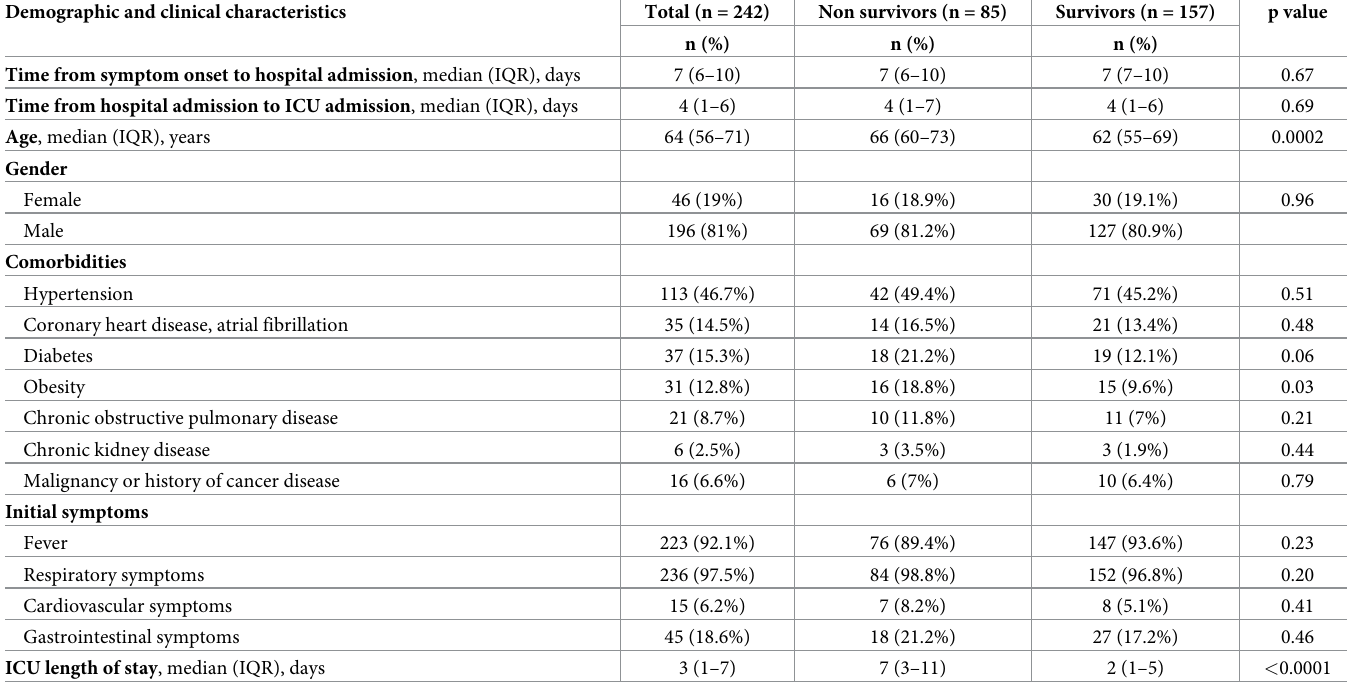
Table 1. Demographic, clinical characteristic, comorbidities and outcomes of 242 patients with COVID-19 admitted to ICU. Data are reported as median, IQR and percentage of the total. Demographic and clinical characteristics Total (n =